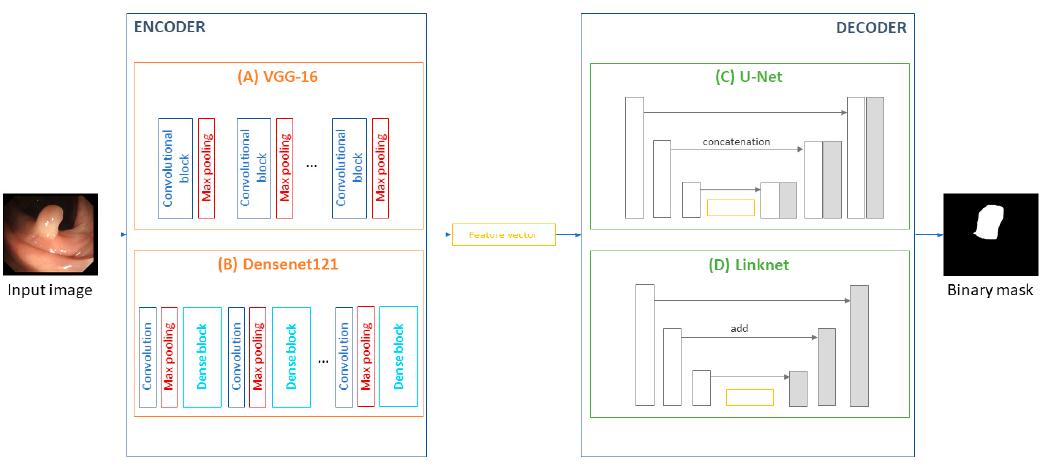
Figure 2. Backbones for the encoder ( A , B ) and encoder-decoder architectures ( C , D ).